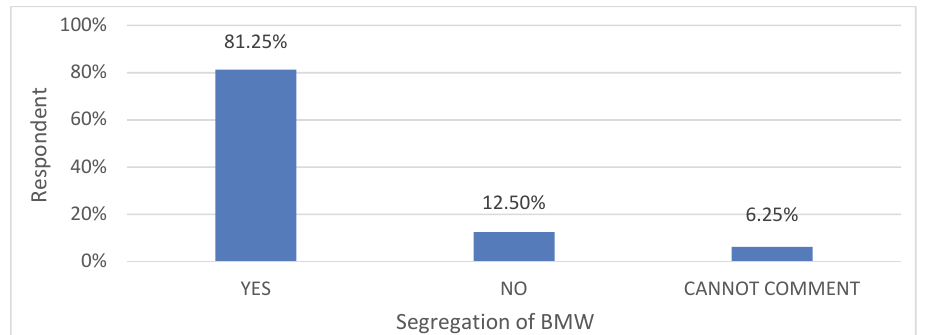
Fig. 1. Segregation of Biomedical waste at Source